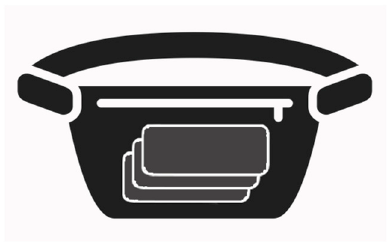
Figure 1. Smartphone rugged belt holster carrying case.